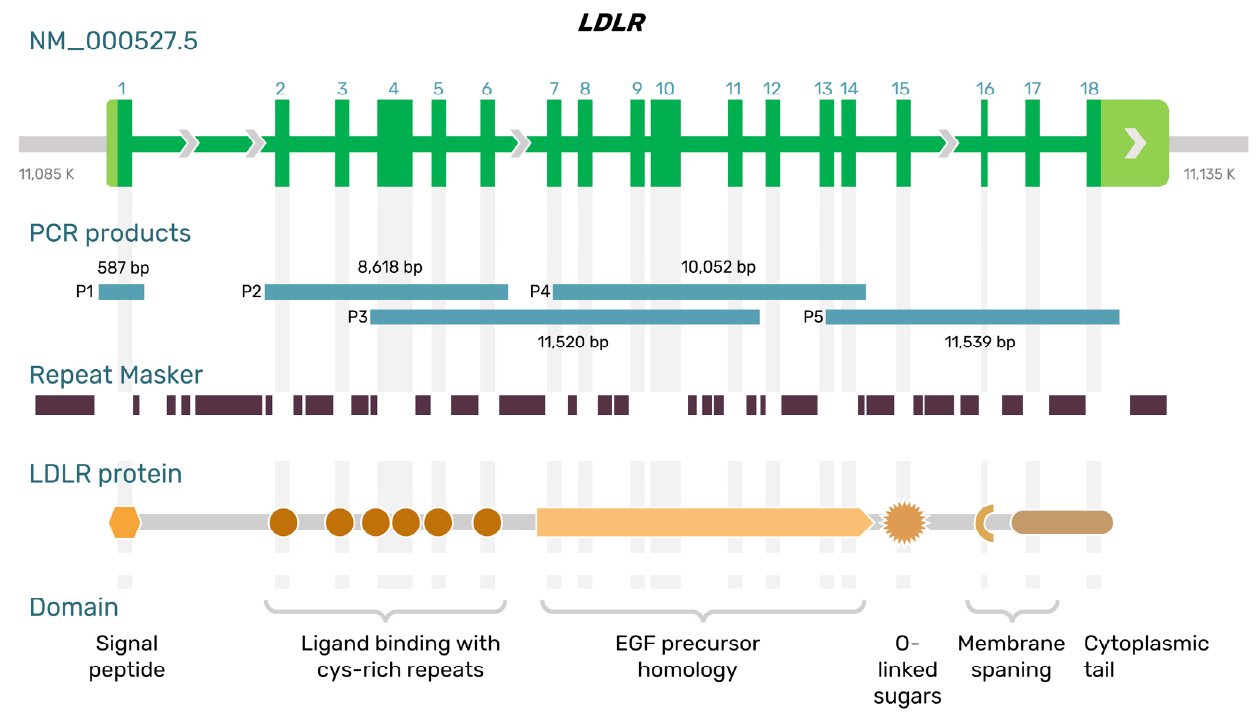
Figure 1. The structure of the LDLR gene and protein. Long-range PCR amplicons (P1–P5) in this study are illustrated by blue lines and size